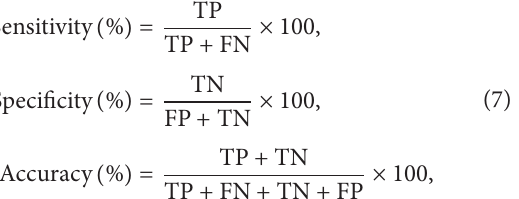
Figure 6: Plotting the number of PLSR factors with the cumulative variance percentage in the response variable 𝑦